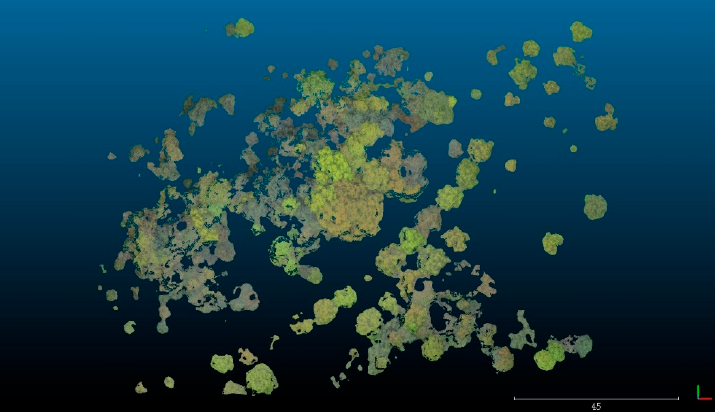
Figure4. Figure 4. The 3D point cloud model after surface reconstruction by the Delauney triangulation algorithm.